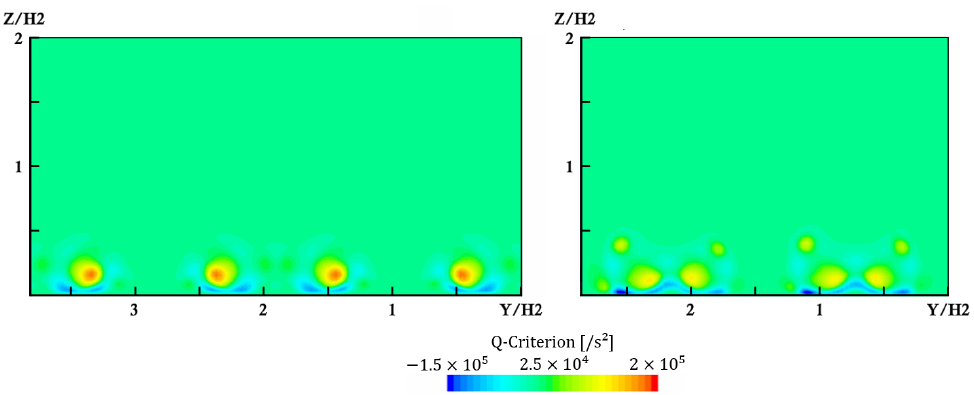
Figure 22. Simulated Q-criterion at the same downstream distance in the wake of the knitted wire meshes. Left : type A at X/H 2 = 13.17, right : type B at X/H 2 = 10.9. The X values represent the same distance downstream in the wake of the different wire